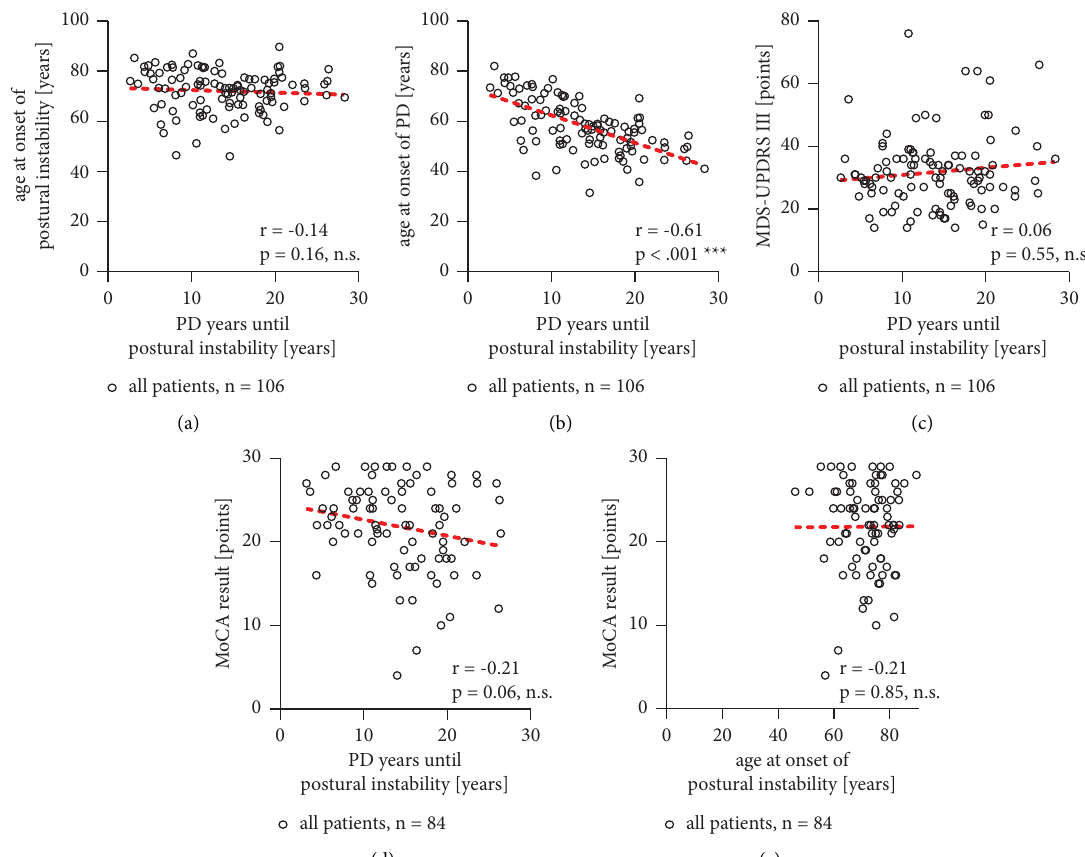
Figure 3: Age at onset of postural instability does not correlate with disease duration. Figure 3 shows the distribution of (a) age at onset of postural instability, (b) age at onset of PD, (c) total MDS-UPDRS III scores, MoCA test results in correlation to the disease duration of PD (graph (d)) ( x -Axis: PD years until postural stability) and MoCA test results in correlation to age at onset of postural instability (e). Te n - numbers are indicated above the graphs, Te red dotted line shows the calculated linear regression. Correlation analysis: R values and p values are indicated in the graphs in the right corner. ∗ Spearman’s test, ∗ p < 0 . 05 statistically